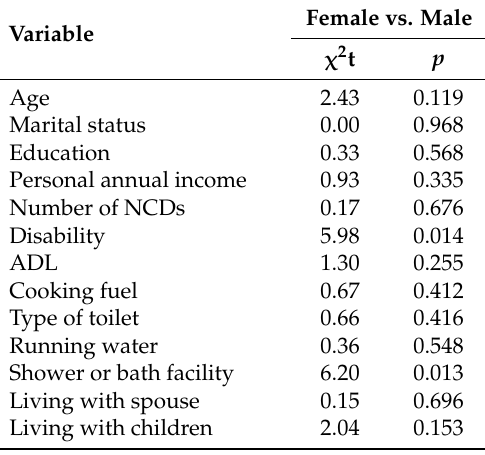
Table 4. Regression coefficients across models: interaction